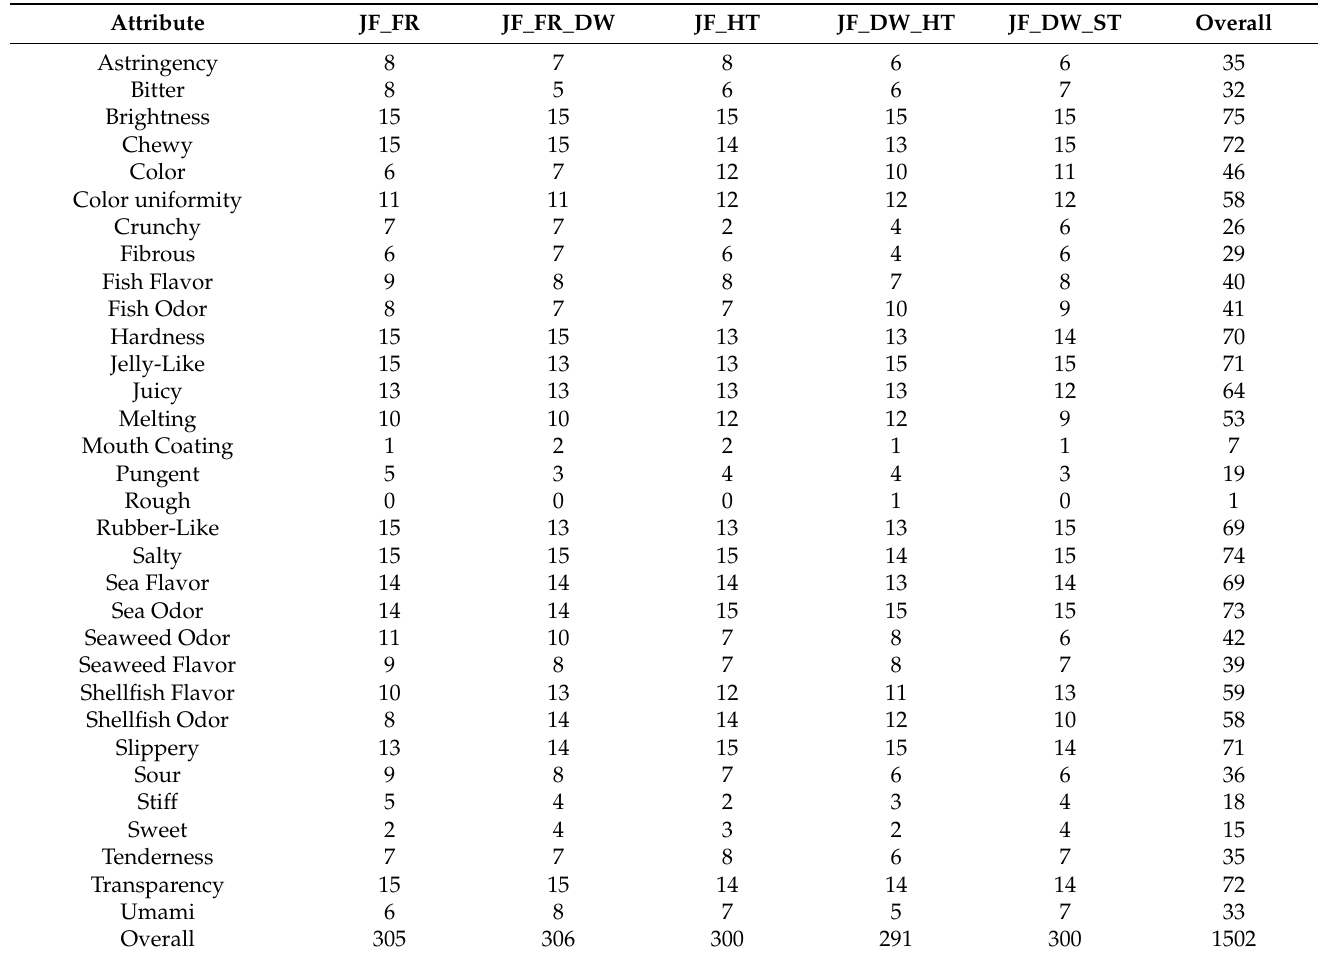
Table 3. Frequency count of the sensory descriptors by samples. Attributes chosen by 30% of the panel are in